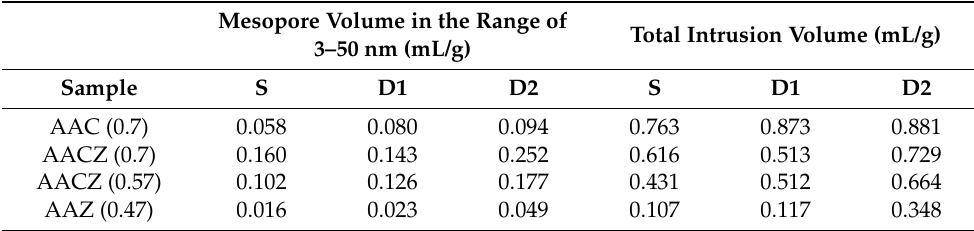
Table 3. Mesopore volume in the range of 3–50 nm (mL/g) and total intrusion volume (mL/g) determined by Hg porosimetry.